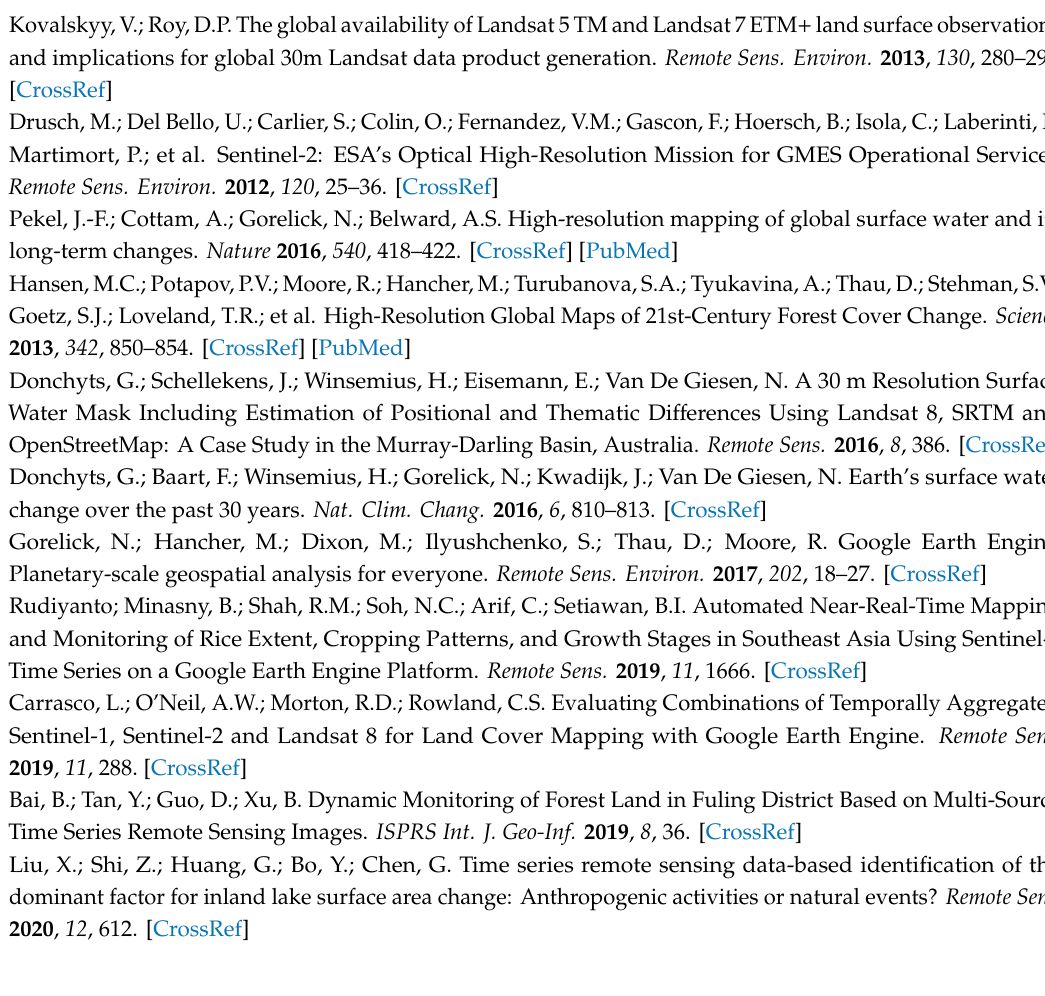
Figure S1: Color composited images (RGB: near-infrared, red, green) of zone 1. ( a – c ) are Sentinel-2 images acquired on May 29, June 18, and July 3, 2020, respectively (1230 × 1200 pixels with 10 m resolution), and ( d – f ) are Sentinel-3 like images aggregated from ( a – c ), Figure S2: Color composited images (RGB: near-infrared, red, green) of zone 2. ( a – c ) are Sentinel-2 images acquired on May 13, June 12, and July 12, 2019, respectively (1530 × 1500 pixels with 10m resolution), and ( d – f ) are Sentinel-3 like images aggregated from ( a – c ), Figure S3: Scatter plots of the observed and predicted reflectance of zone 1 from the four data fusion methods in green (B3), red (B4), and near-infrared (B8) bands, respectively, Figure S4: Scatter plots of the observed and predicted reflectance of zone 2 from the four data fusion methods in green (B3), red (B4), and near-infrared (B8) bands, respectively, Table S1: Accuracy assessment results of the four data fusion methods. Root mean square error (RMSE), average di ff erence (AD), average absolute di ff erence (AAD), and correlation coe ffi cient r, near-infrared